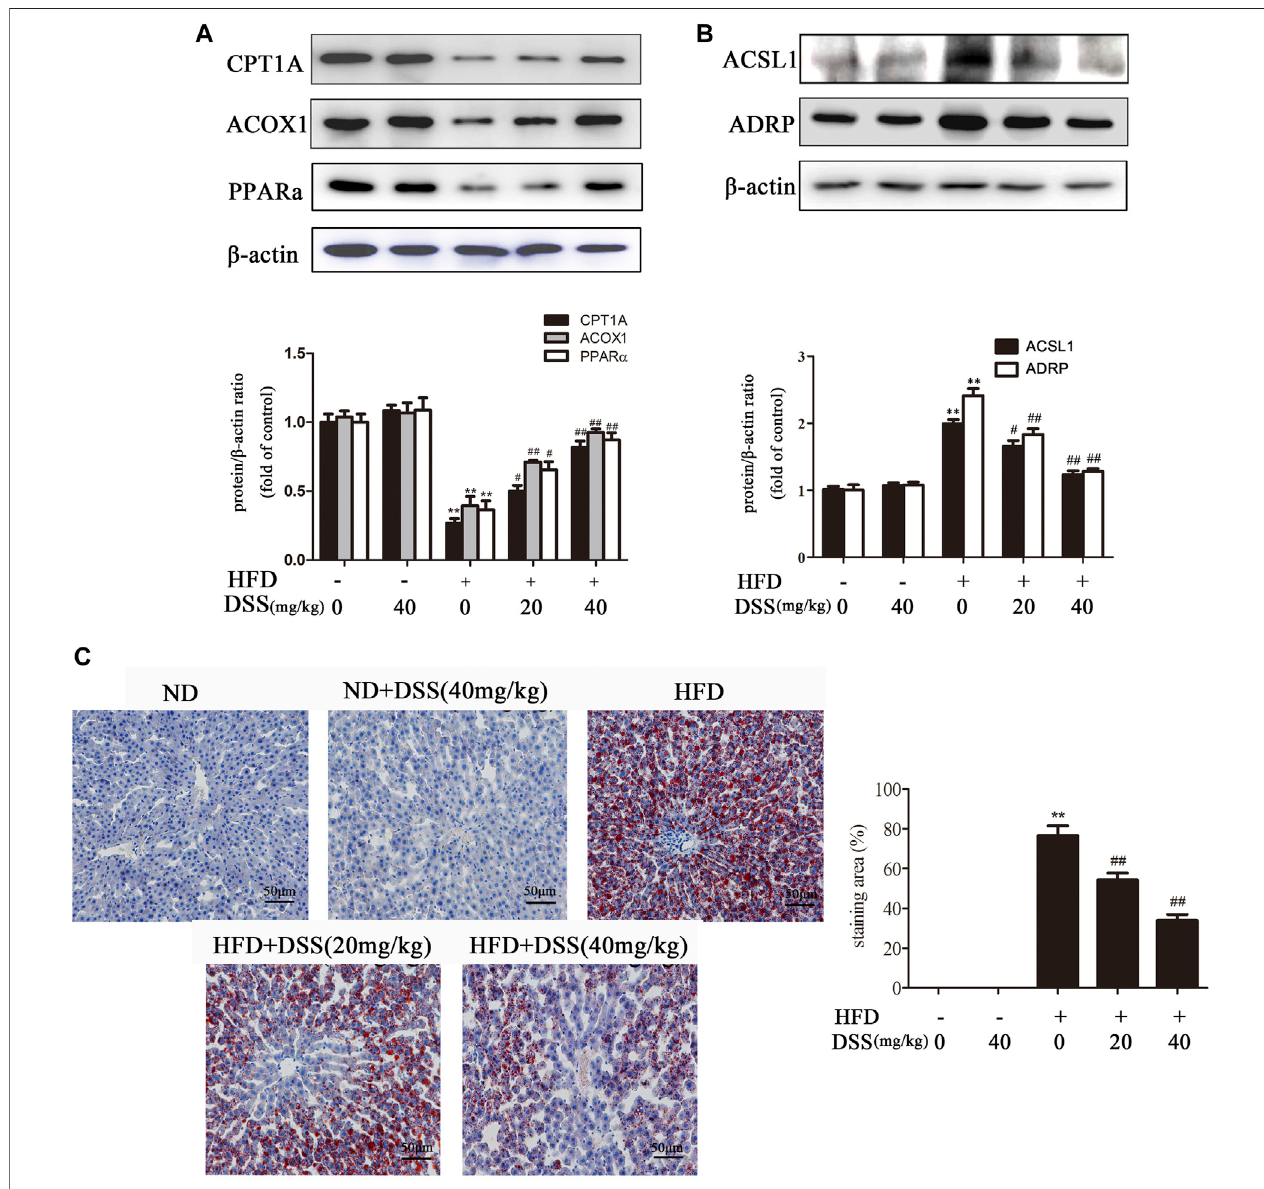
FIGURE 2 | DSS increases fatty acid β -oxidation and attenuates LD accumulation in rats. (A,B) Western blot analysis of fatty acid β -oxidation-related genes (CPT1A,ACOX1andPPAR α )andLDaccumulation-relatedgenes(ACSL1andADRP)proteinlevelsintheliver( n (cid:2) 3). (C) OilRedO-stainedimagesofliversectionsfrom the following experimental groups: the ND, DSS (40 mg/kg), HFD, HFD + DSS (20 mg/kg) and HFD + DSS (40 mg/kg) groups. Oil Red O-stained sections were photographed at 400 × magni fi cation. ** p < 0.01 vs. the ND group; # p < 0.05, ## p < 0.01 vs. the HFD group.